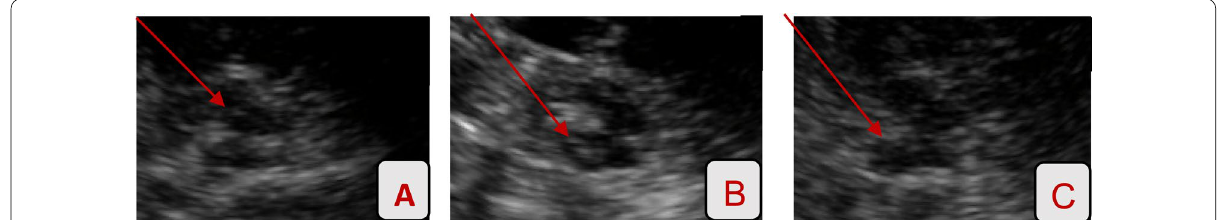
Fig. 2 Abnormal echogenicity of the SN. A – C show normal echogenicity, increasing echogenicity, and area decreasing echogenicity, respectively